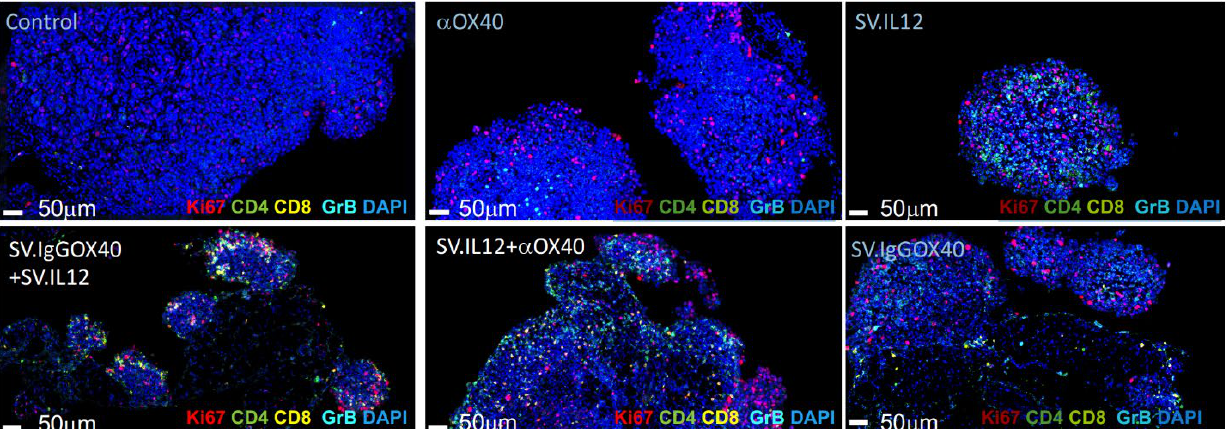
Figure 7. Tumors of mice treated with armed Sindbis vectors expressing IL-12 or α OX40 display increased tumor-infiltrating immune T cells. Intra-tumoral T-cell immune responses were assessed by multiplex immunofluorescence staining in tumors isolated from tumor-bearing mice. MOSEC.Fluc.p11 tumor-bearing mice were left untreated, or were treated with α OX40, SV.IL-12 (upper lane left to right) or SV.IgGOX40+SV.IL-12 (50% injection mix), SV.IL-12+ α OX40, or SV.IgGOX40 single-vector (lower panel left to right). Representative images of T-cell infiltration are shown for indicated groups. Proteins of interest were stained and are indicated by color in each image: Ki-67 (red), CD4 (green), CD8 (yellow), granzyme B (turquoise), and DAPI nuclear staining appears in blue.